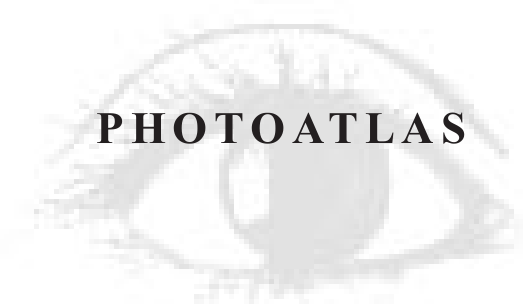
* DipOptom MPhil DPhil(RAU) CAS(NewEnCO) FAAO